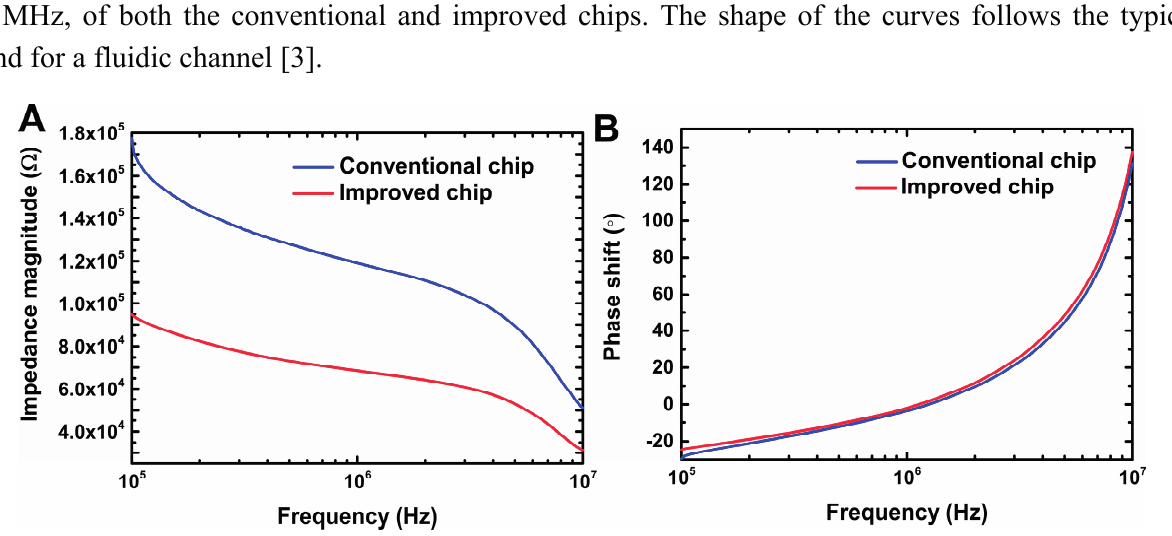
Figure 4. Frequency sweep of chips used for the experimental work. ( A ) Impedance magnitude as a function of frequency for the conventional and improved chips. ( B ) Phase shift/angle as a function of frequency for the conventional and improved